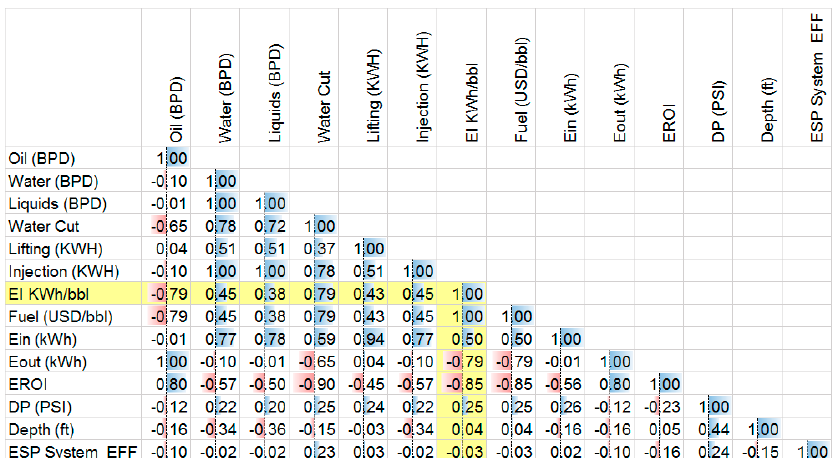
Figure 11. Correlation matrix.